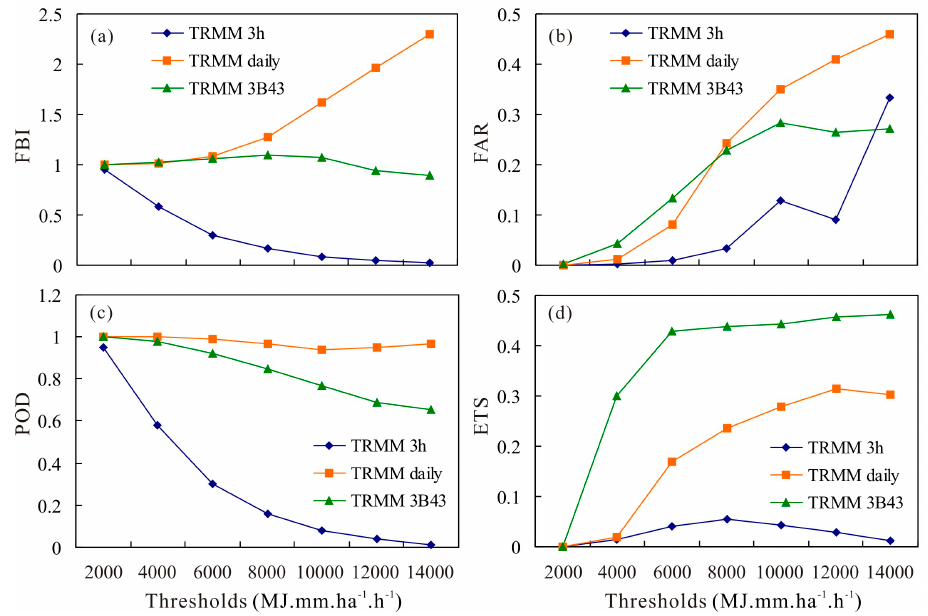
Figure 8. Changes in the frequency bias index ( a ), the false alarm ratio ( b ), the probability of detection ( c ) and the equitable threat score ( d ) at different rainfall erosivity thresholds. ( c ) and the equitable threat score ( d ) at di ff erent rainfall erosivity